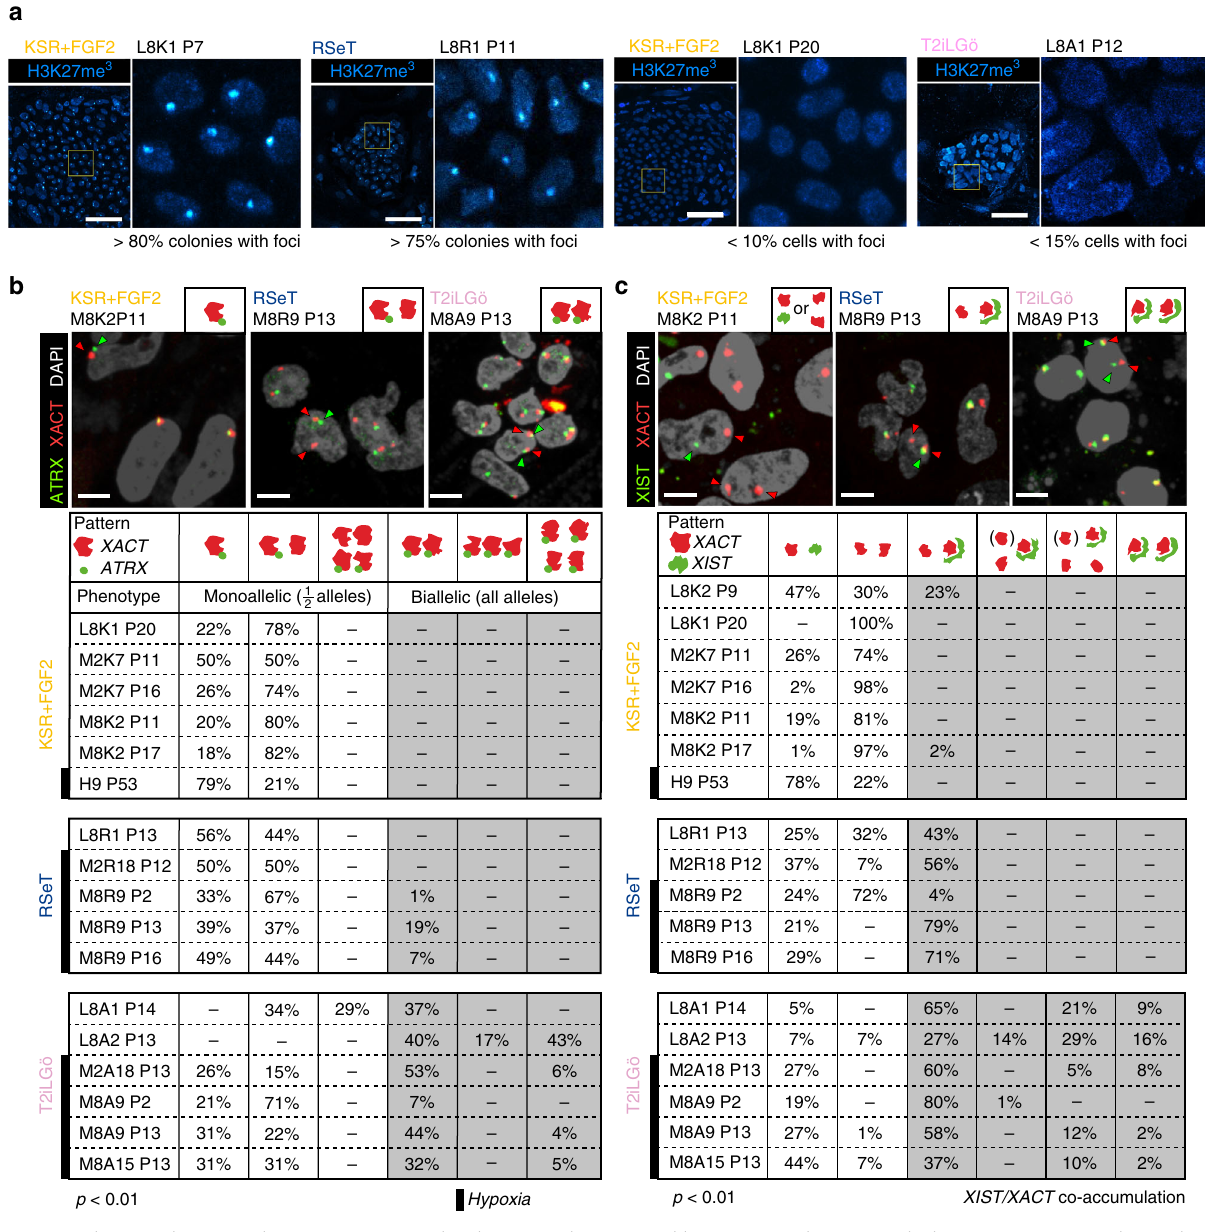
Fig. 5 T2iLGö hiNPSCs have a X-chromosome status related to preimplantation epiblast. a T2iLGö hiNPSCs or high-passage KSR-FGF2 do not display H3K27me3 foci. Indicated cell lines were analyzed by immuno fl uorescence for H3K27me3. This experiment is representative of three technical replicates performed at different passages of the cell lines. Scale bar = 50 µ m. b , c T2iLGö hiNPSCs show signs of X-chromosome reactivation. mRNA FISH analysis for b ATRX and XACT or c XIST and XACT . For each cell line represented, more than 100 cells were investigated for their nuclear expression of the indicated mRNA. Quanti fi cations for each combination are indicated below pictures. For each table, samples distribution between FISH counting were found statistically different ( p < 0.01) by a homogeneity χ 2 test. Scale bar = 20 µ negative, reprogramming was performed. Each iPSC line generated was tested for mycoplasma using the MycoAlert kit at various time points to ensure mycoplasma absence in both primed and naive hiPSCs.